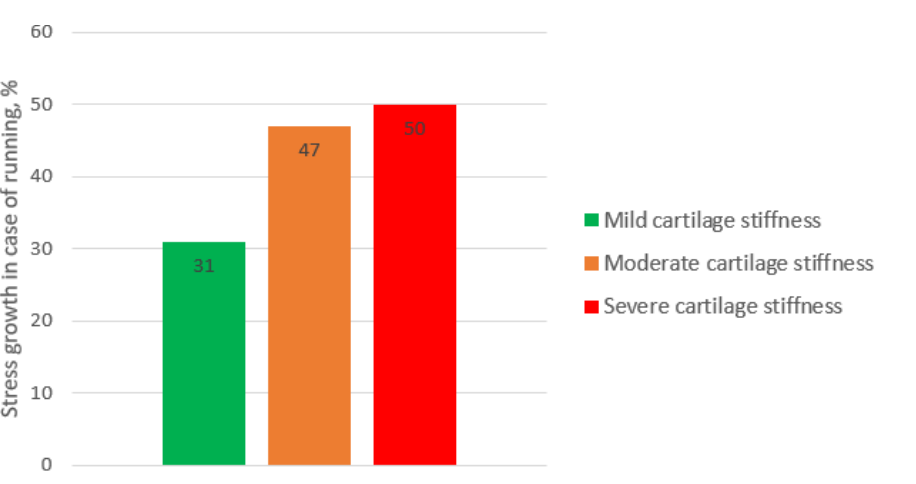
Figure 15. Maximum von Mises stress percentage growth in case of running.